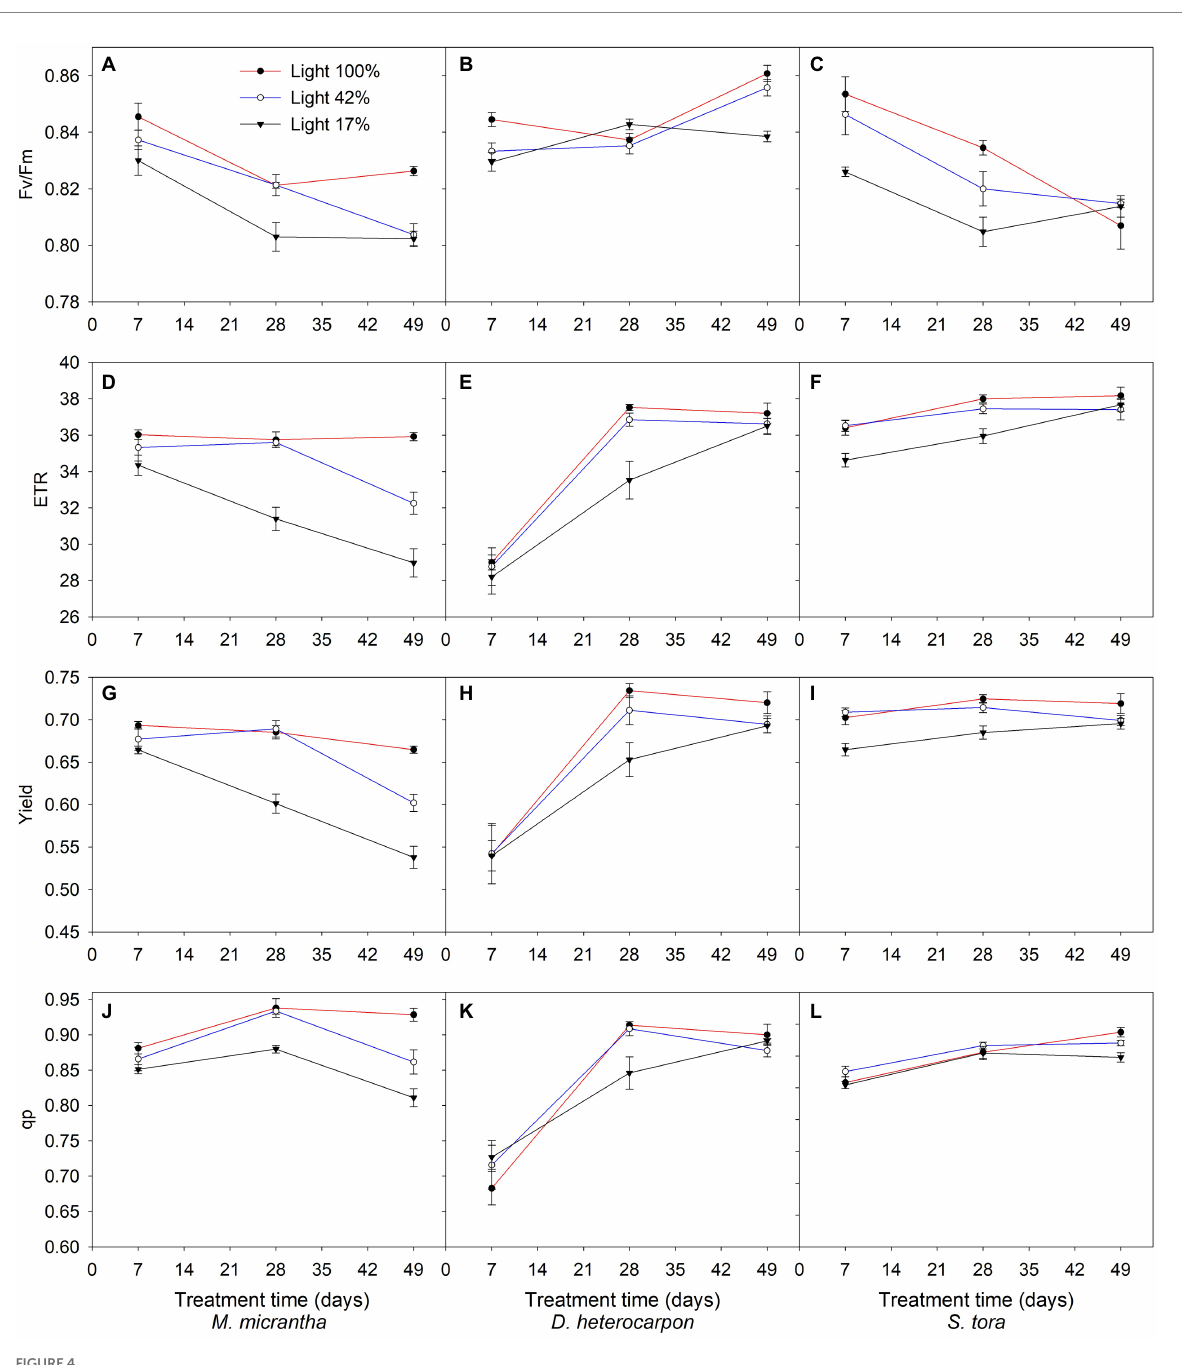
(Figure 9A). Under drought treatment, the soluble sugar content of M. micrantha , D. heterocarpon, and S. tora increased significantly by 72.4, 28.9, and 31% respectively, compared with the well-watered treatment. The soluble sugar content of all three plants recovered to a level comparable to the well-watered group after rehydration (Figure 9B).